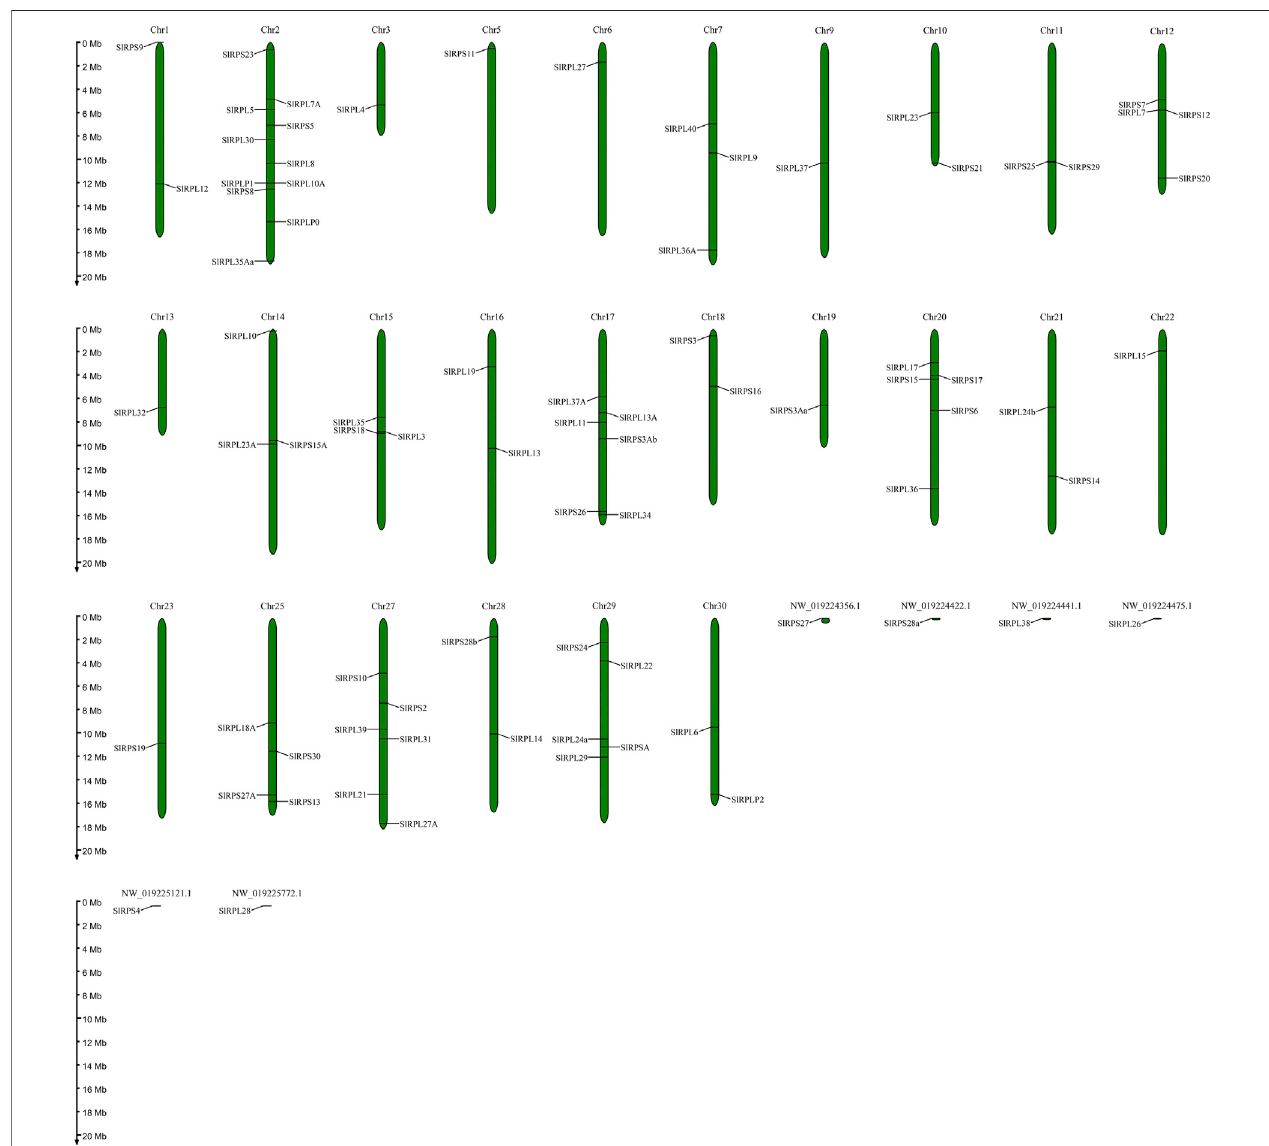
FIGURE 1 | Chromosomal distribution of SlRp